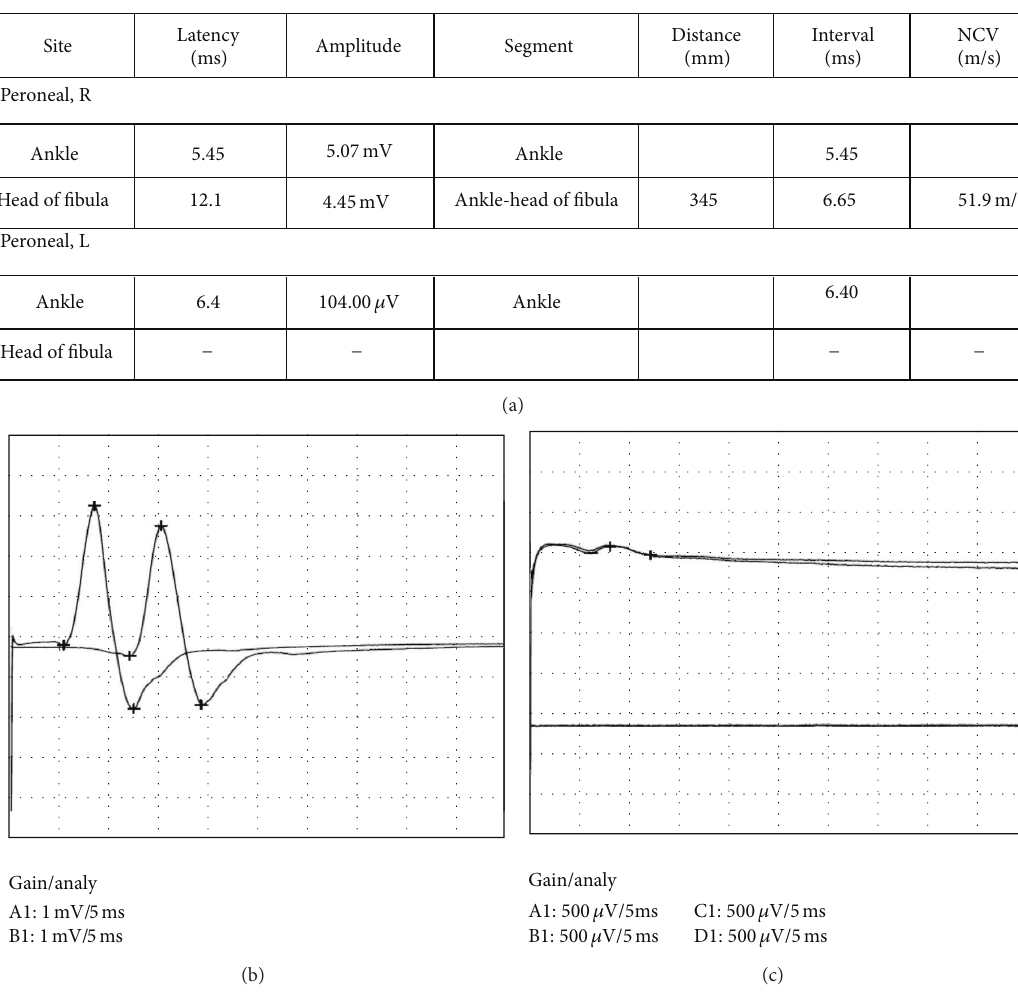
Figure 1: (a) The result of the motor nerve conduction velocity showed the left peroneal nerve palsy. (b) The nerve conduction velocity of the right peroneal nerve. (c) The nerve conduction velocity of the left peroneal nerve. The left peroneal nerve conduction velocity could not be derived 5 days after